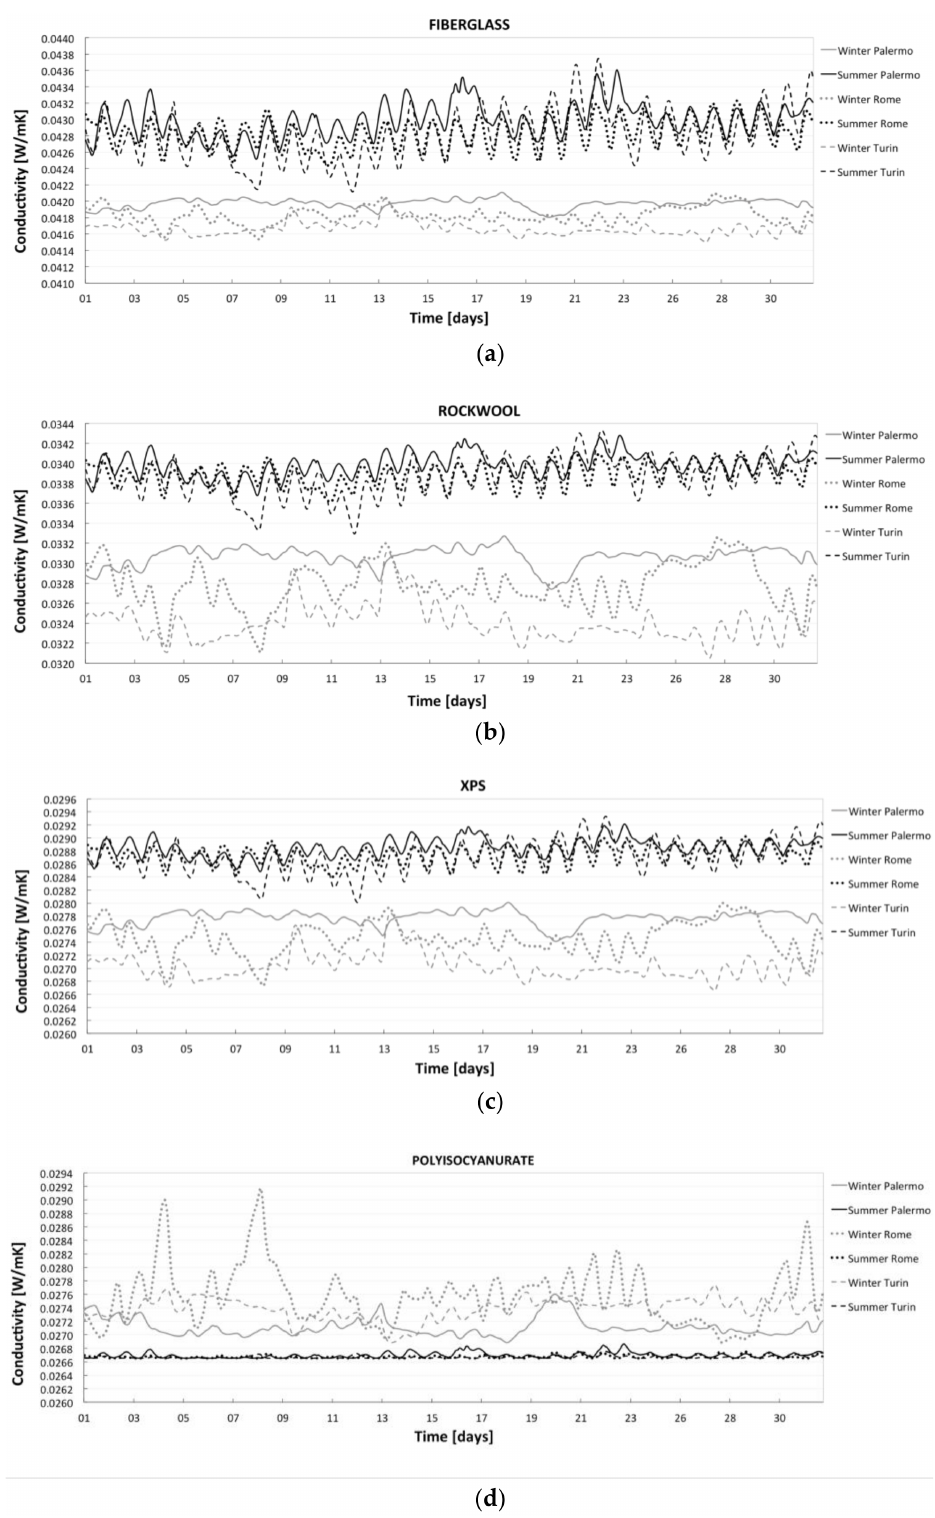
Figure 4. Time series of thermal conductivity values of insulation materials in external